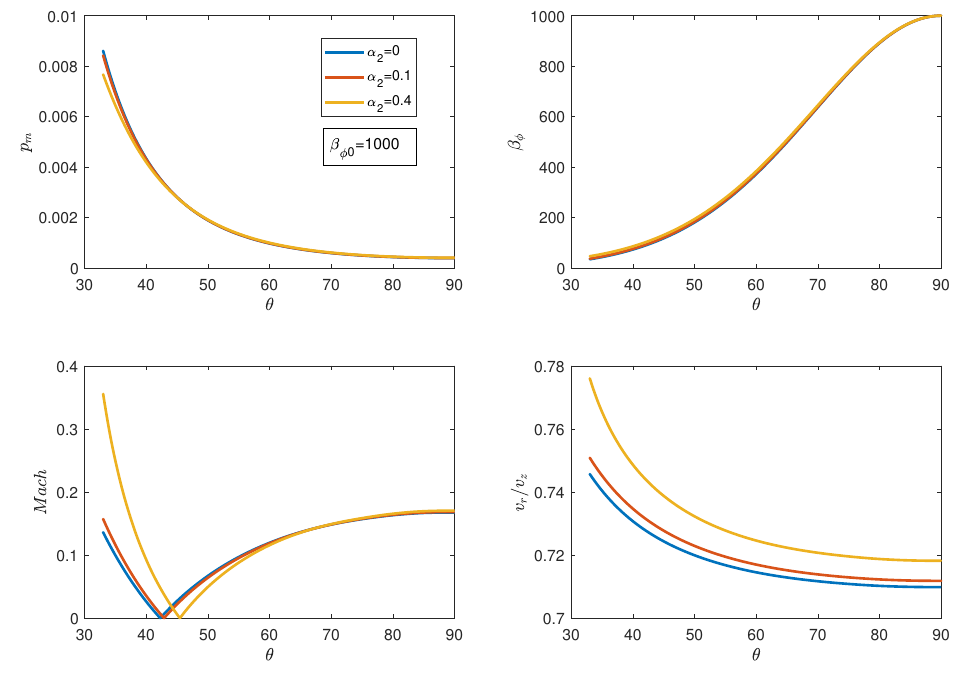
Figure 2. The magnetic pressure ( p m ), the ratio of gas pressure to magnetic pressure ( β φ ), Mach number ( | v r / c s | ), and v r / v z change with θ . The blue, red, and yellow lines correspond to α 2 = 0.0, 0.1 and 0.4, respectively. Here, the gas pressure is 10 times larger than the magnetic pressure at the